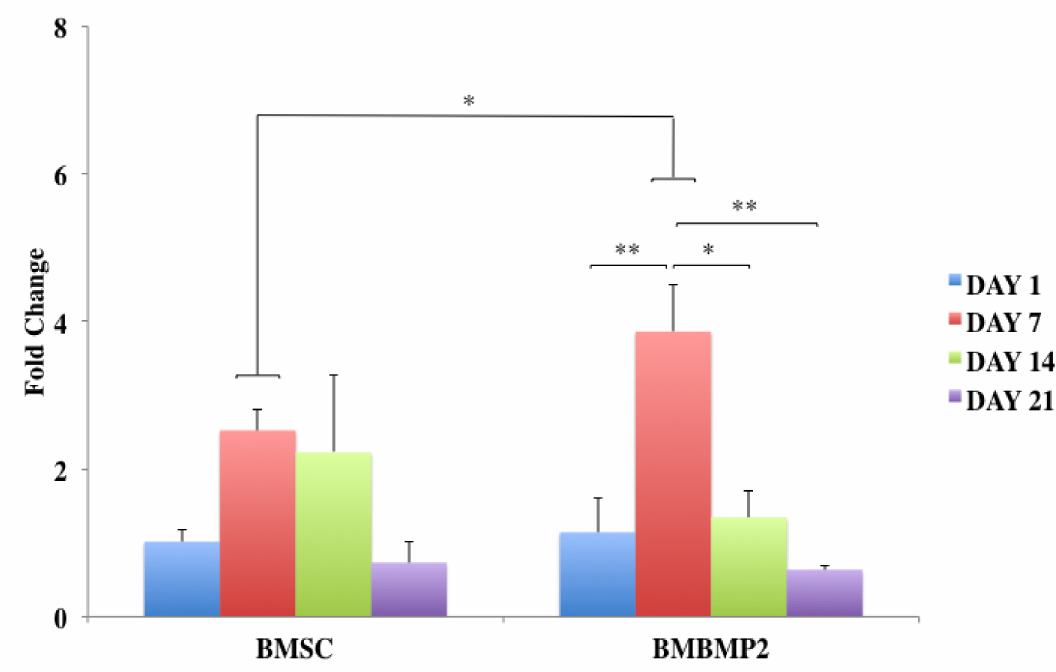
Figure 8. Shows cFOS expression, gene associated with cell cycle and growth, at days 1, 7, 14, and 21. X -axis shows control groups of photoencapsulated-BMSCs without BMP-2 (BMSCs) and experimental groups of photoencapsulated-BMSCs with BMP-2 (BMBMP2). Y -axis shows fold change. cFOS is expressed at day 7 in experimental group (BMBMP2) compared to control group (BMSCs). Statistical significance is set at: * = p < 0.05 and ** = p < 0.01, (N = 4 ±